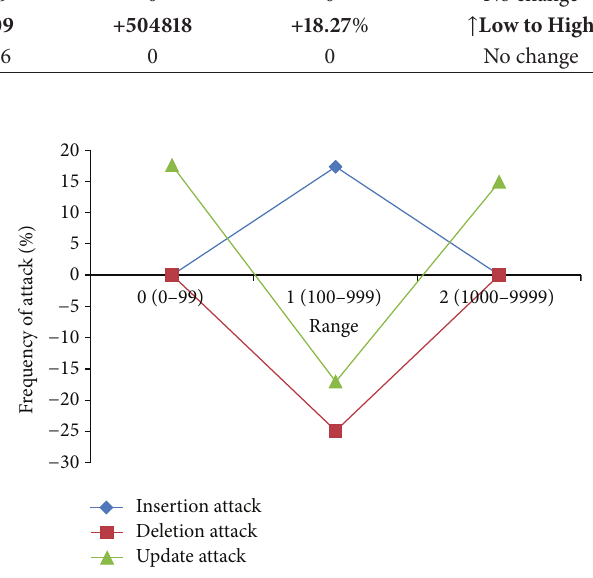
Figure 6: Characterization of malicious insertion, deletion, and update attacks on range 1 (100–999) of data